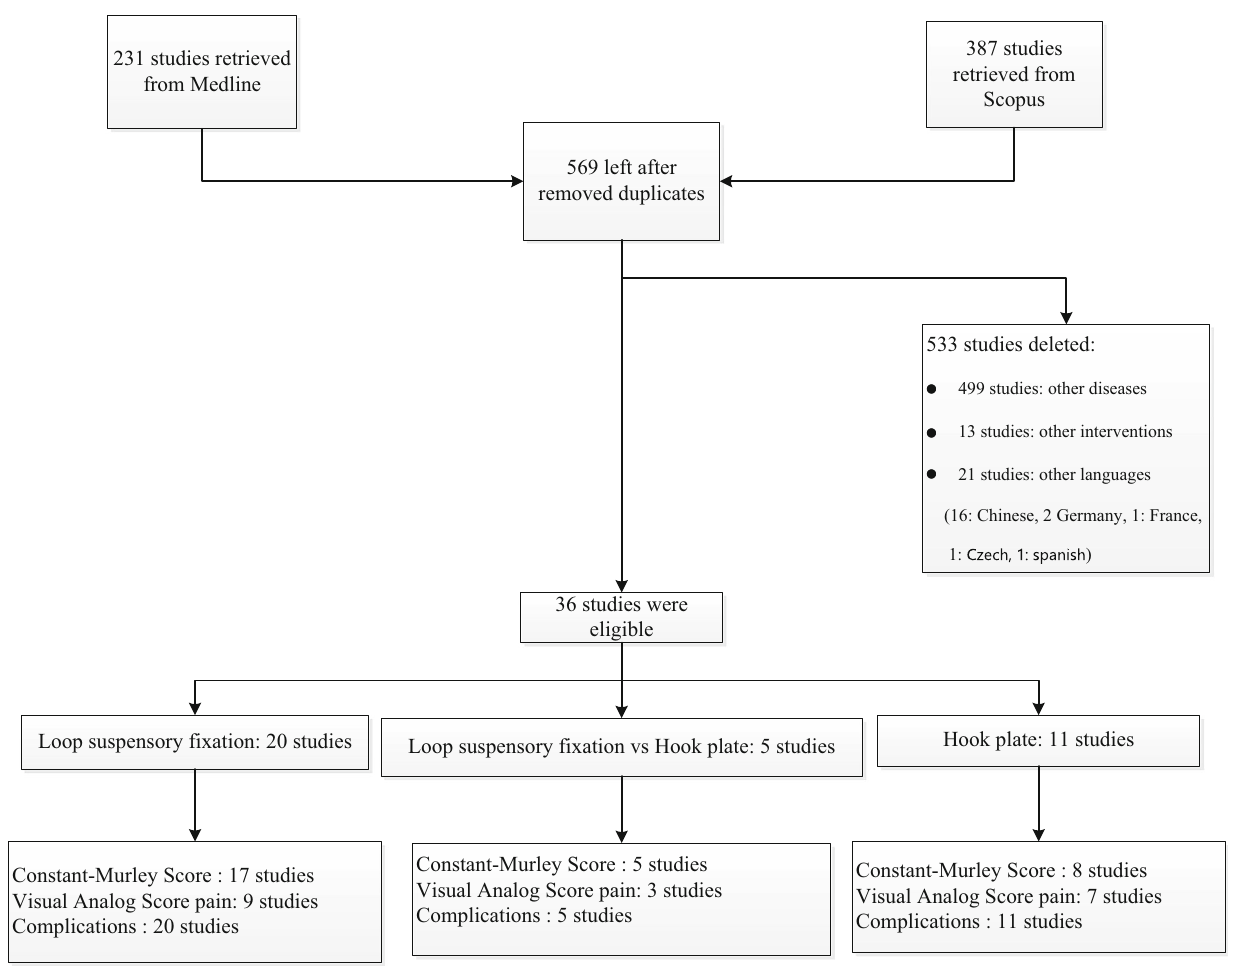
Fig. 1 Flow of study